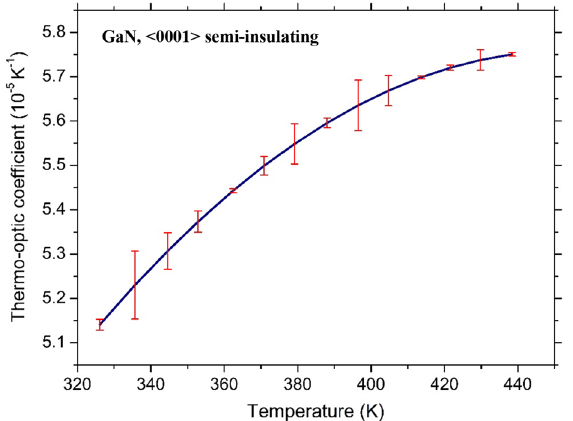
Figure 7. Polynomial fit and error bar of thermo-optic coefficient of GaN at the wavelength of 1.55